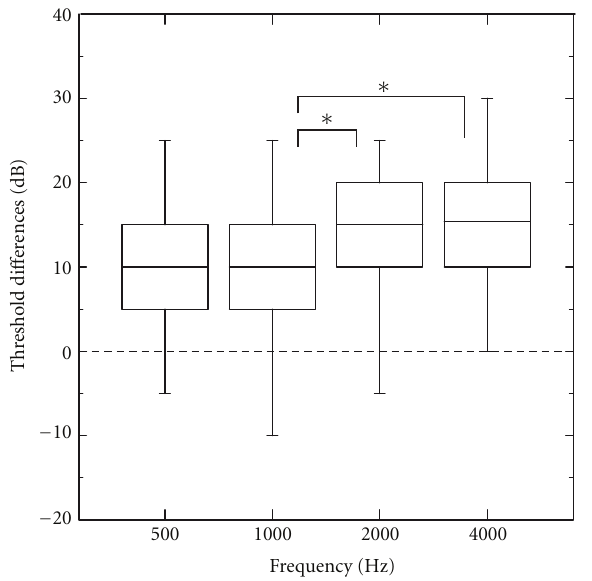
Figure 4: Residual noise of the test runs which were used for the “no-response” decision at four test frequencies for 32 subjects. Outer limits of each box represent the 25th and 75th percentiles, with the median shown as the line within the box. Whiskersindicate the 5th and 95th percentiles. (Bonferroni’s post hoc tests: ∗ P < 0 .